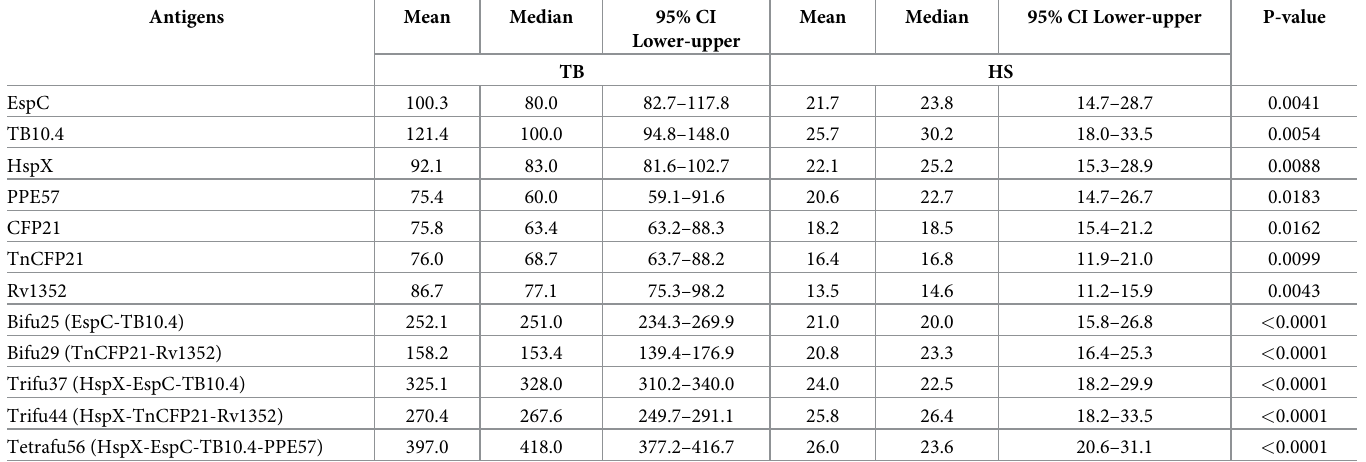
Table 3. Statistical data for the release of IFN- γ (pg/mL) by PBMCs from the TB and healthy subjects against the single antigens and their fusion constructs.